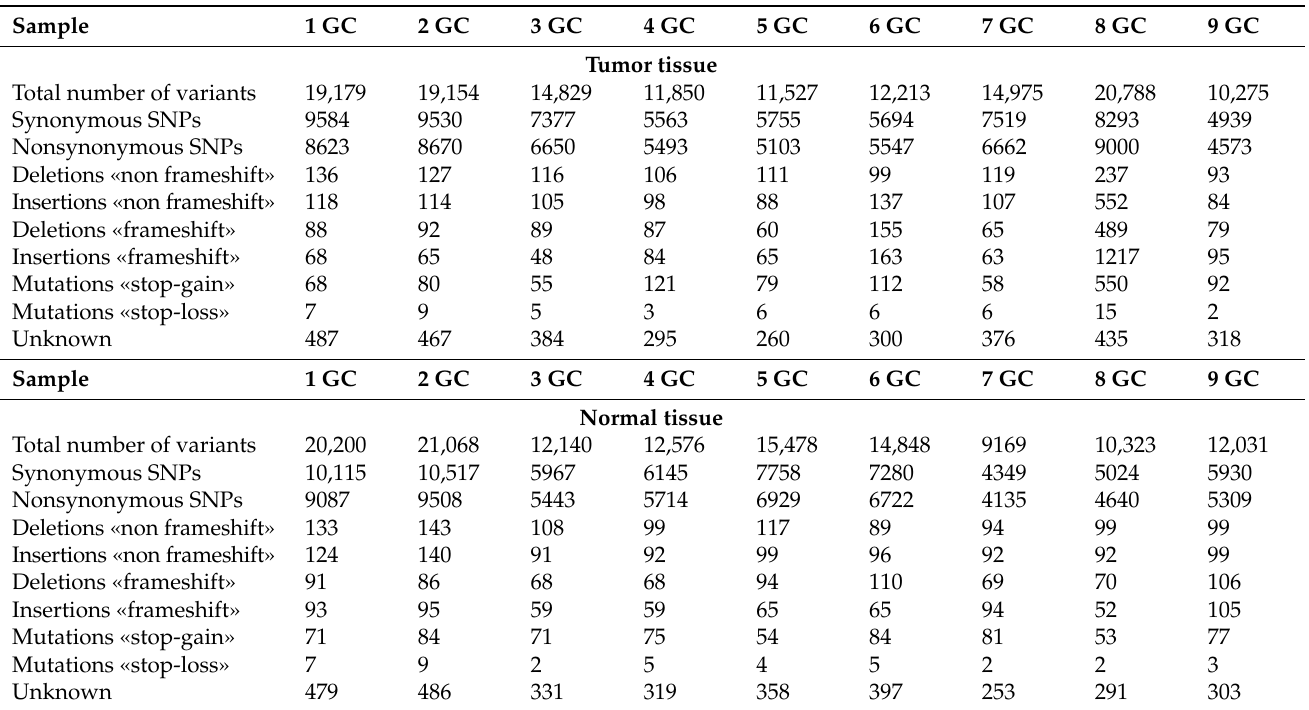
Table 2. Quantitative distribution of variants, located in exons and splicing regions, according to their functional